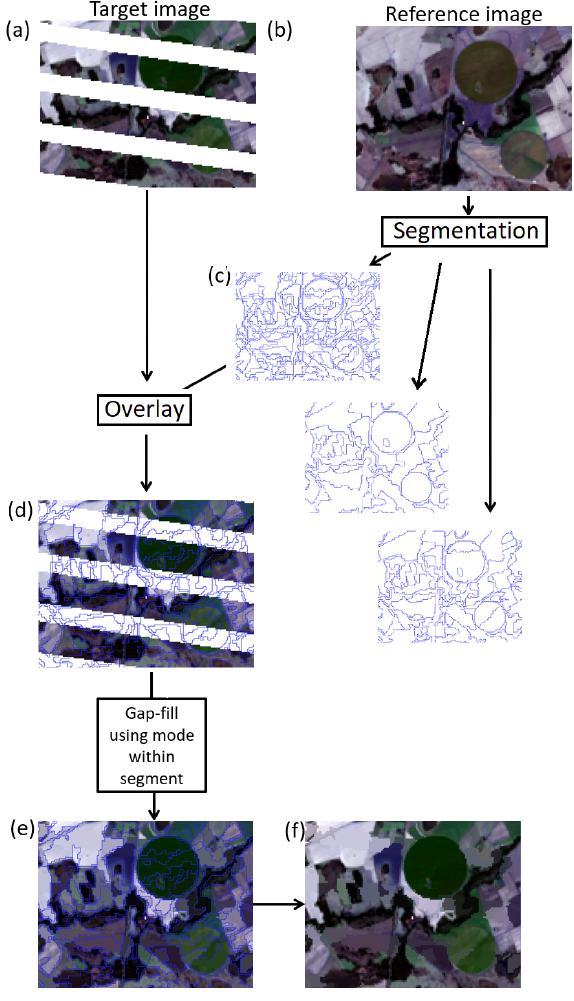
Figure 1: A subset of Landsat-7/ETM+ SLC-off image (path/row 220/75) showing the missing data gaps size, smaller at the center of the image (top image) reaching 14 pixels in width near image borders (bottom image).